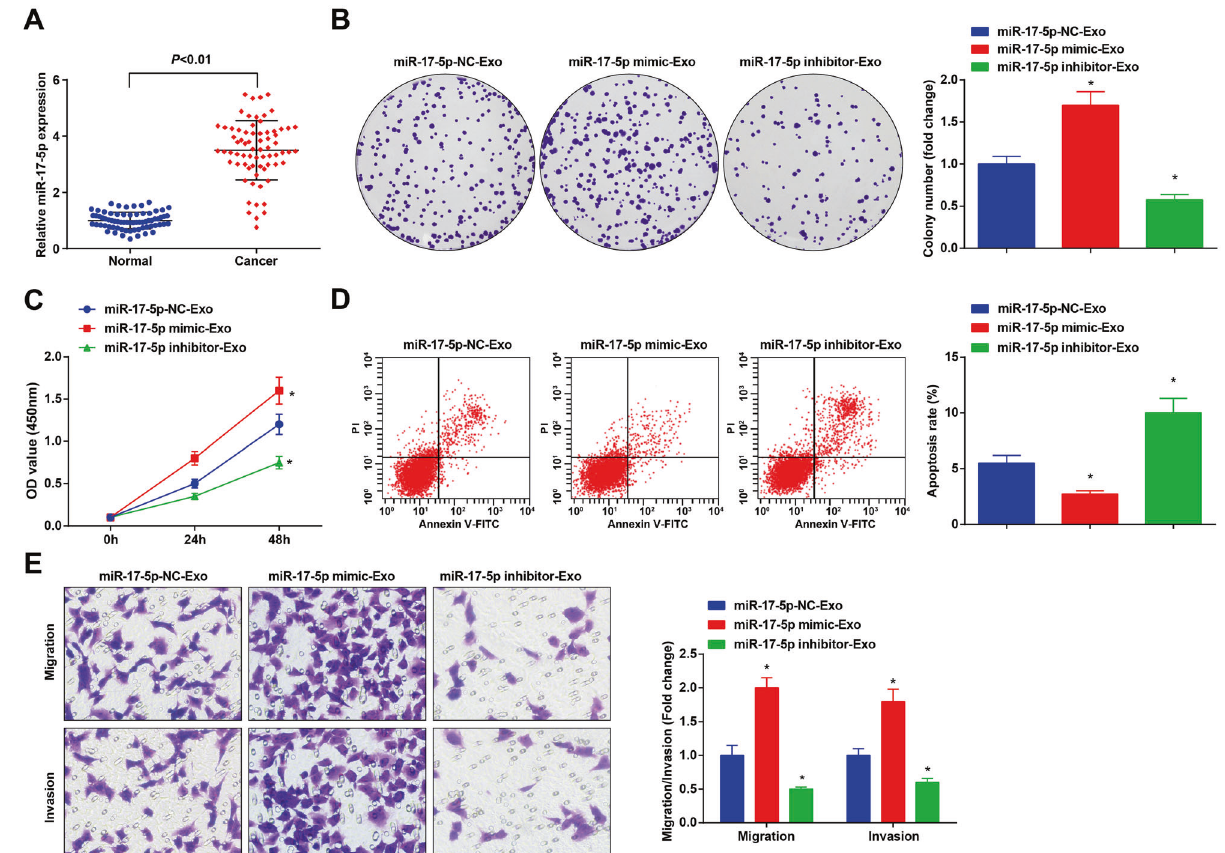
Fig. 4 CRCSC-exos upregulating miR-17-5p facilitates malignant behaviors of HCT116 cells. A miR-17-5p expression in CRC tissues and adjacent normal tissues detected using RT-qPCR ( n = 70); B proliferation of HCT116 cells detected using colony-formation assay after treated with CRCSC-exos transmitting miR-17-5p mimic/inhibitor; C proliferation of HCT116 cells detected using CCK-8 assay after treated with CRCSC- exos transmitting miR-17-5p mimic/inhibitor; D apoptosis of HCT116 cells detected using fl ow cytometry after treated with CRCSC-exos transmitting miR-17-5p mimic/inhibitor; E migration and invasion of HCT116 cells detected using Transwell assay after treated with CRCSC- exos transmitting miR-17-5p mimic/inhibitor. The cell experiments were repeated three times; * P < 0.05 vs the miR-17-5p-NC-Exo group; the measurement data were expressed as mean ± standard